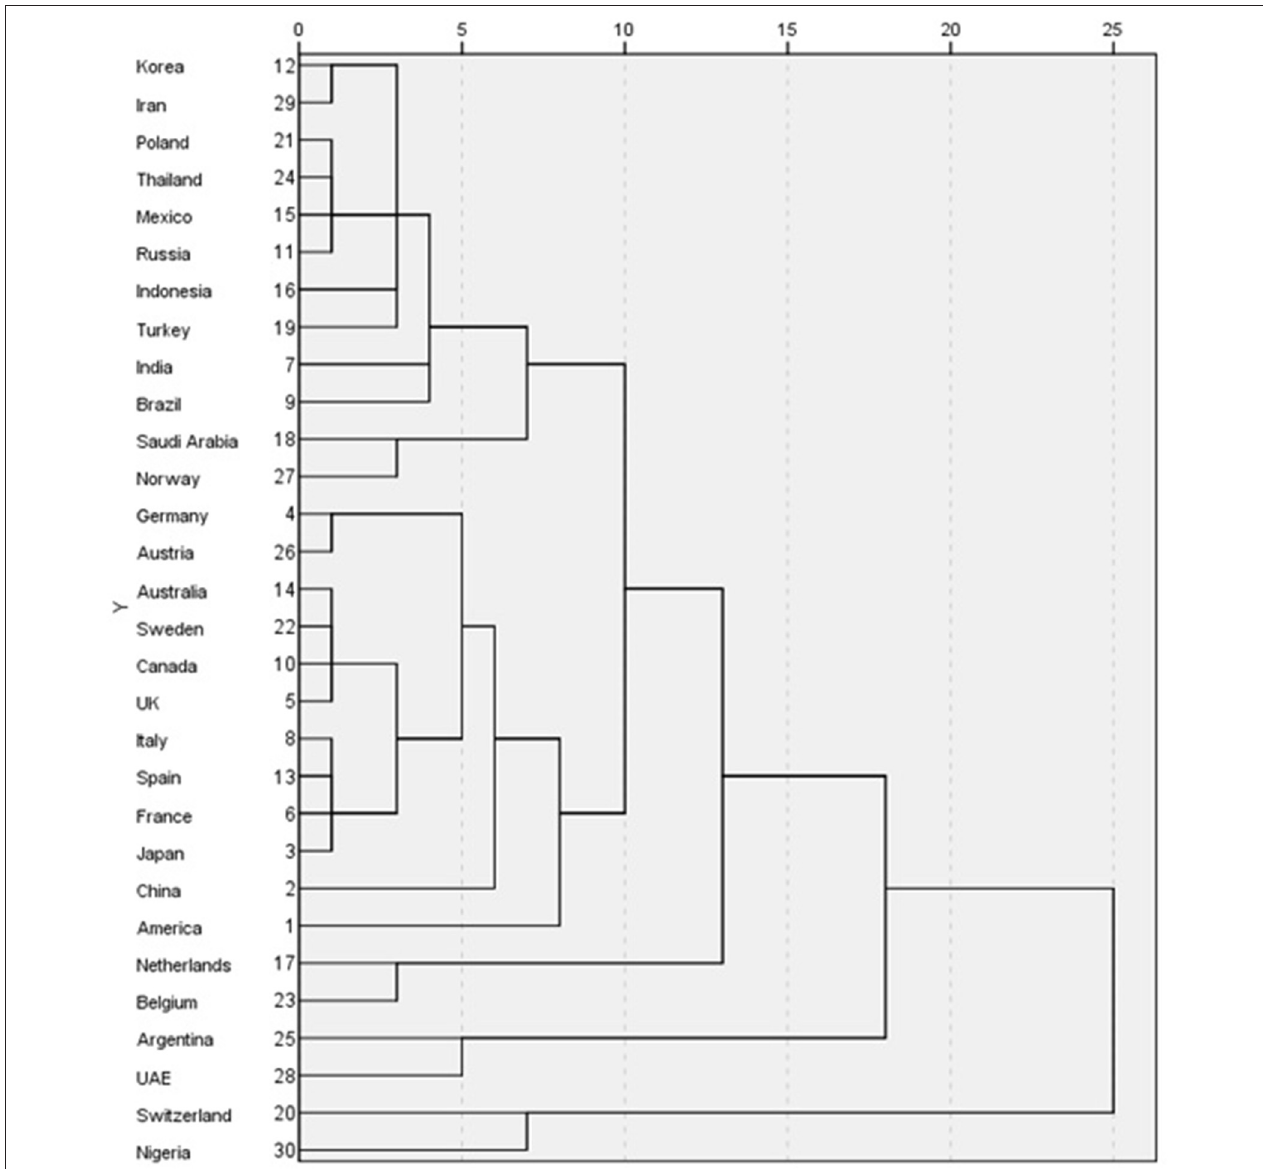
FIGURE 2 | Tree diagram of smart beds market